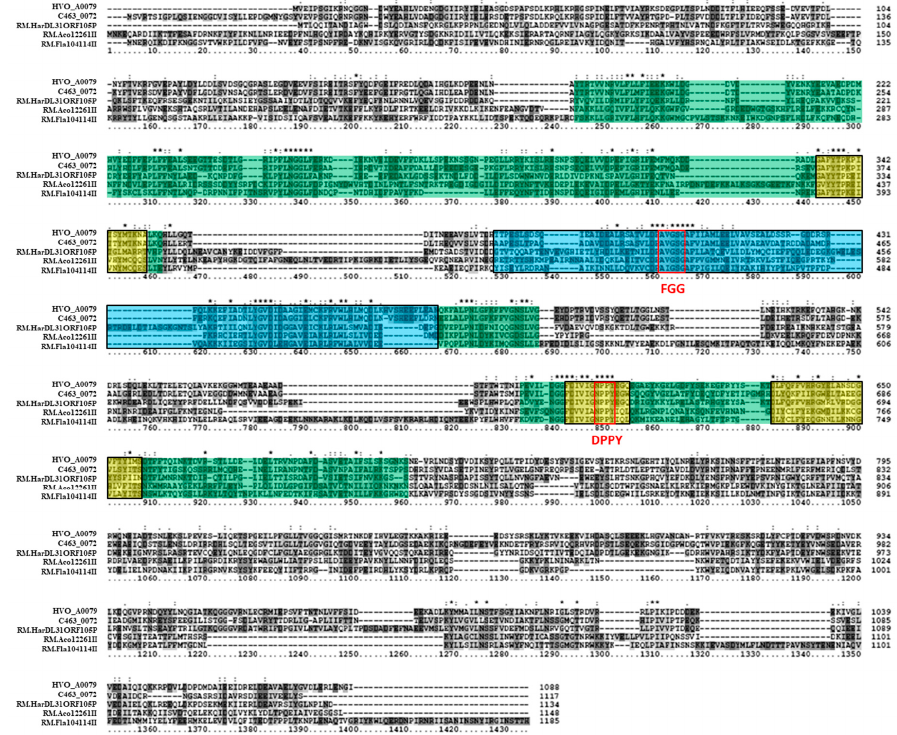
Figure 7. Amino acid alignment of HVO_A0079 homologs. The multiple sequence alignment includes HVO_A0079 ( Haloferax volcanii DS2; GenBank ADE01706), C463_0072 ( Halorubrum californiensis DSM 19288; GenBank ELZ48543), RM.HarDL31ORF105P ( Halophilic archaeon DL31; GenBank AEN07377), RM.Aco12261II ( Aminobacterium colombiense DSM 12261; GenBank ADE57453), and RM.Fla104114II ( Filimonas lacunae 104114; GenBank BAV07385). The PRINTS adenine-specific DNA methyltransferase signature domains PR00507 are highlighted in yellow. Red boxes signify signature FGG and DPPY motifs. The SCOP superfamily domain S -adenosyl- L -methionine-dependent methyltransferase domain SSF53335 is highlighted throughout the alignment. Clustal X2 shading and marking of amino acids is included in the alignment.